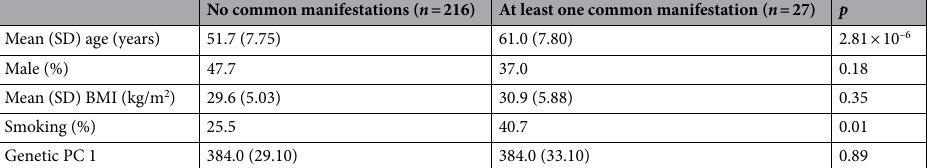
No common manifestations ( n = 216) At least one common manifestation ( n = 27)